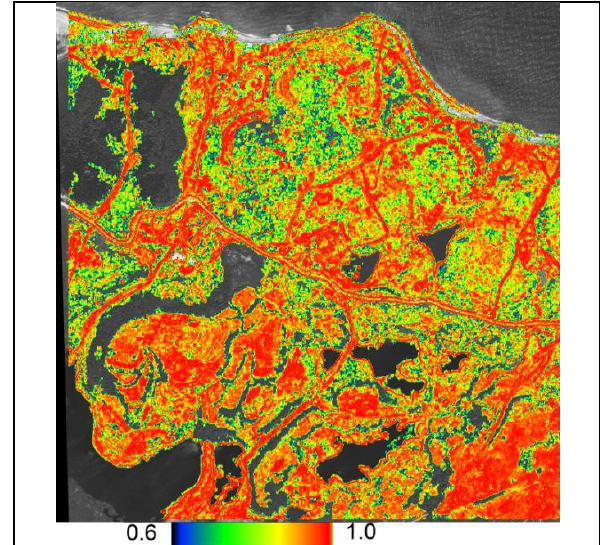
Fig. 8 : color coded size of correlation coefficients in a sub-area matched with 0.5m GSD images, correlation threshold =0.6, in grey = used image for matching in the not accepted area